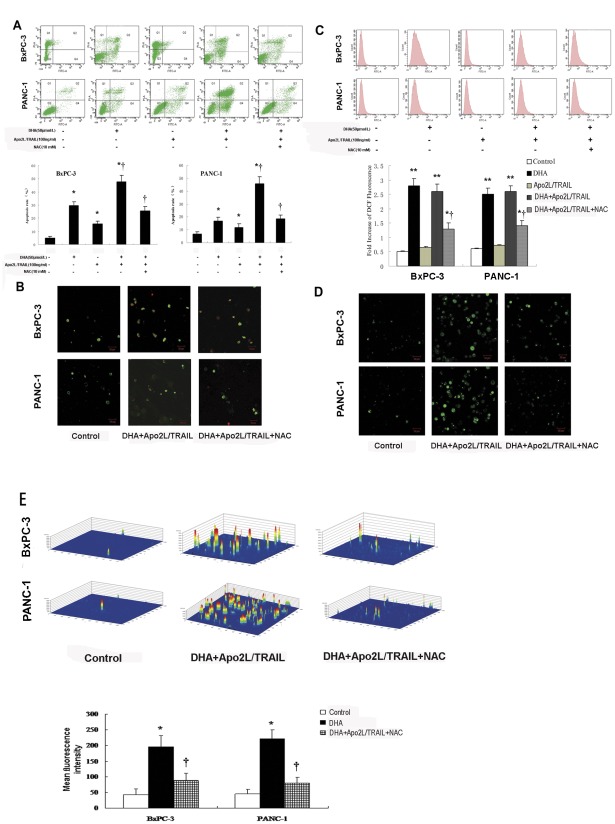
DHA-induced apoptosis is caused by ROS.(A) Apoptosis of pancreatic cancer cells. BxPC-3 and PANC-1 cells were treated with DHA (50 µmol/L) and Apo2L/TRAIL (100 ng/ml) as indicated. Flow cytometry was performed to measure apoptosis rates (%). A significant increase in the apoptosis rate compared with the control is denoted by “*” (P<0.05), a significant increase compared with DHA- or Apo2L/TRAIL-treated cells is denoted by “†” (P<0.01), and a significant decrease compared with DHA+Apo2L/TRAIL-treated cells is denoted by “‡” (P<0.01). Representative histograms from cytometrically analyzed BxPC-3 and PANC-1 cells treated with control, DHA, Apo2L/TRAIL, DHA+Apo2L/TRAIL or NAC (10 mM). (B) Laser scanning confocal microscopy of cells. Representative photographs were taken of the control BxPC-3 and PANC-1 cells and of BxPC-3 and PANC-1 cells treated with DHA+Apo2L/TRAIL and DHA+Apo2L/TRAIL+NAC. (C) Levels of intracellular ROS measured in vitro. BxPC-3 and PANC-1 cells were treated with DHA (50 µmol/L), Apo2L/TRAIL (100 ng/ml), DHA+Apo2L/TRAIL, or pretreated with NAC (10 mM) and then treated with DHA+Apo2L/TRAIL for 6 h. Untreated cells served as the control. The cells were incubated with DCFHDA and then subjected to flow cytometry to measure the levels of intracellular ROS, as represented by DCF fluorescence. A significant increase in DCF fluorescence compared with the control is denoted by “*” (P<0.05), a highly significant difference compared with the control is denoted by “**” (P<0.01), and a significant reduction compared with the DHA+Apo2L/TRAIL treatment is denoted by “†” (P<0.05). (D) Representative photographs are shown for DCFHDA-stained cells observed using laser scanning confocal microscopy. The green fluorescence represents intracellular ROS. (E) The mean fluorescence intensity was measured for the DCFHDA-stained cells, and the respective 3-dimensional horizontal plane images were produced by laser scanning confocal microscopy. A significant difference from the control is denoted by “*” (P<0.01), and a significant difference from the DHA+Apo2L/TRAIL treatment is denoted by “†” (P<0.05).